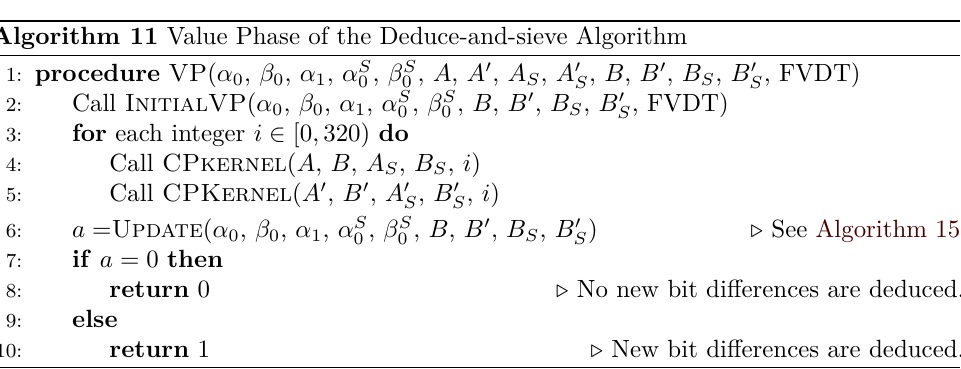
Algorithm 11 Value Phase of the Deduce-and-sieve